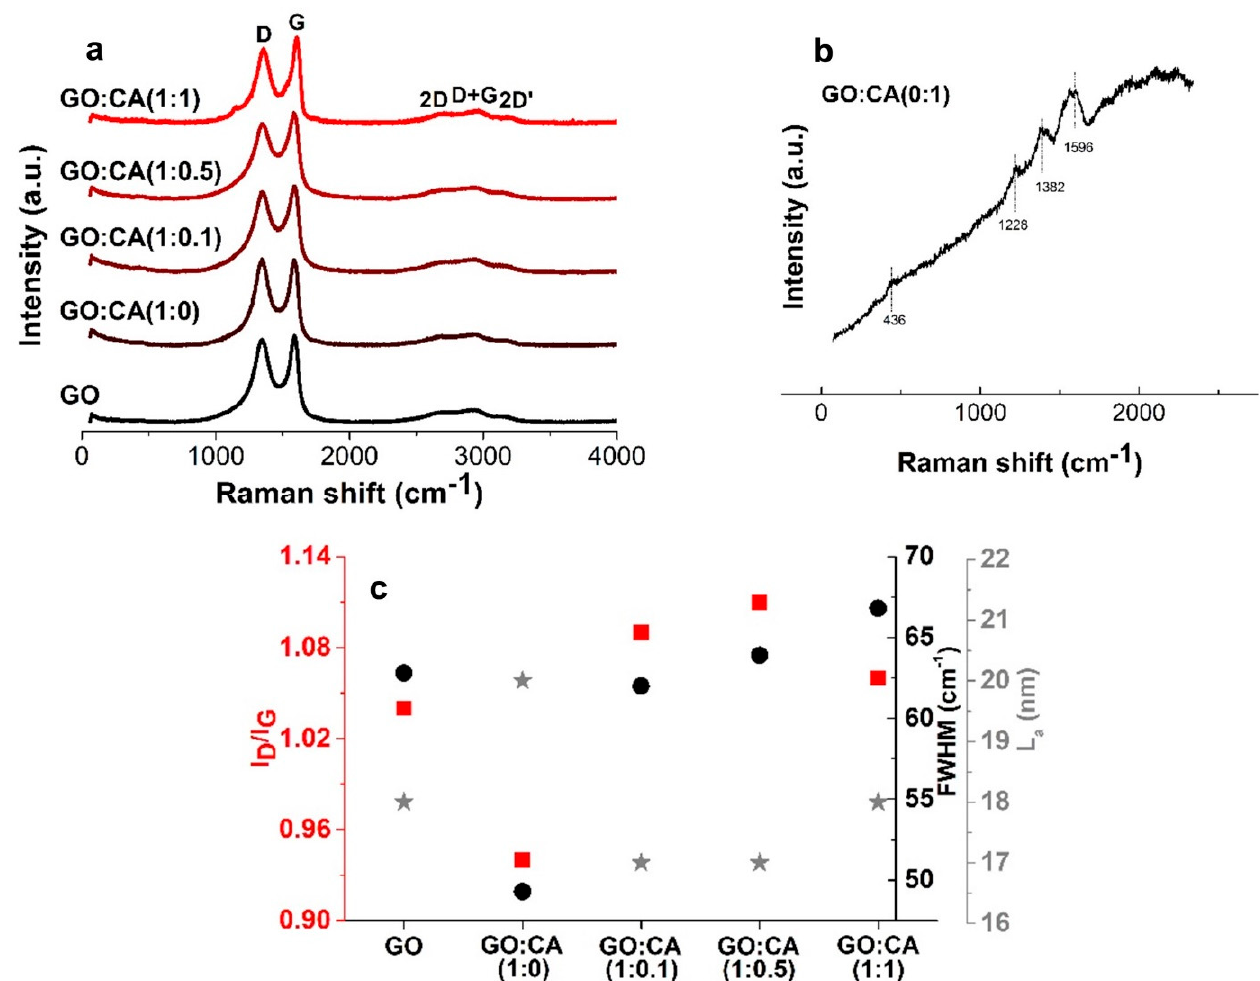
Figure 5. Raman spectra of ( a ) GO and reduced samples ( b ) GO:CA (0:1) sample. ( c ) D and G bands intensity (I D /I G ) represented with red squares, full width at half maximum (FWHM) represented with black circles, and in-plane size of the sp 2 domain (L a) values represented with grey stars, of GO and reduced samples.